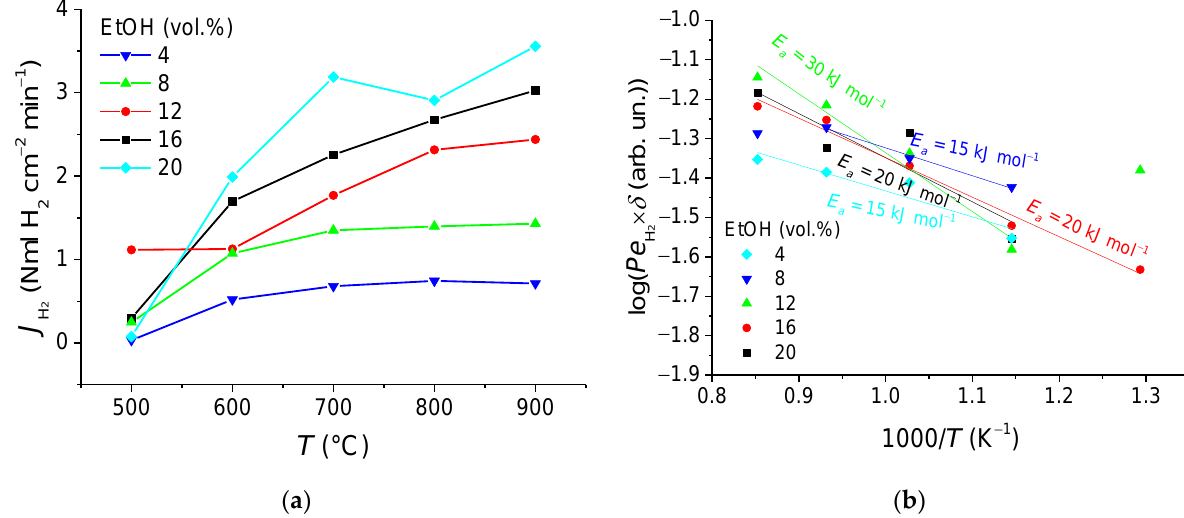
Figure 11. Hydrogen flux dependences on temperature ( a ) and corresponding Arrhenius plots ( b ) for S/E = 4 at different fuel concentrations.